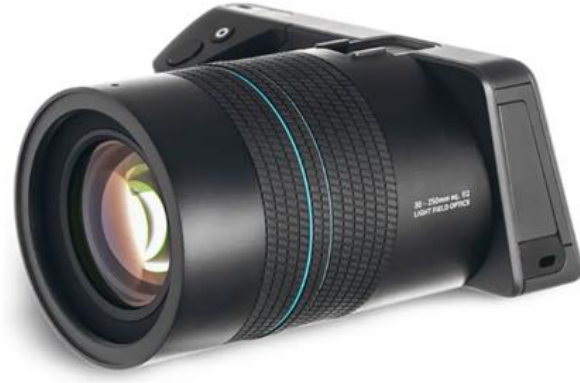
Figure 6. Lytro Illum light field camera.